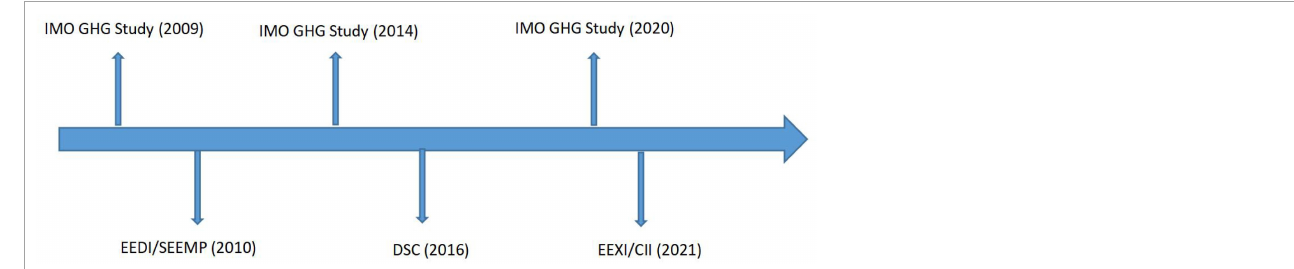
TABLE 2 Timeline for IMO GHG Study and shipping emission reduction